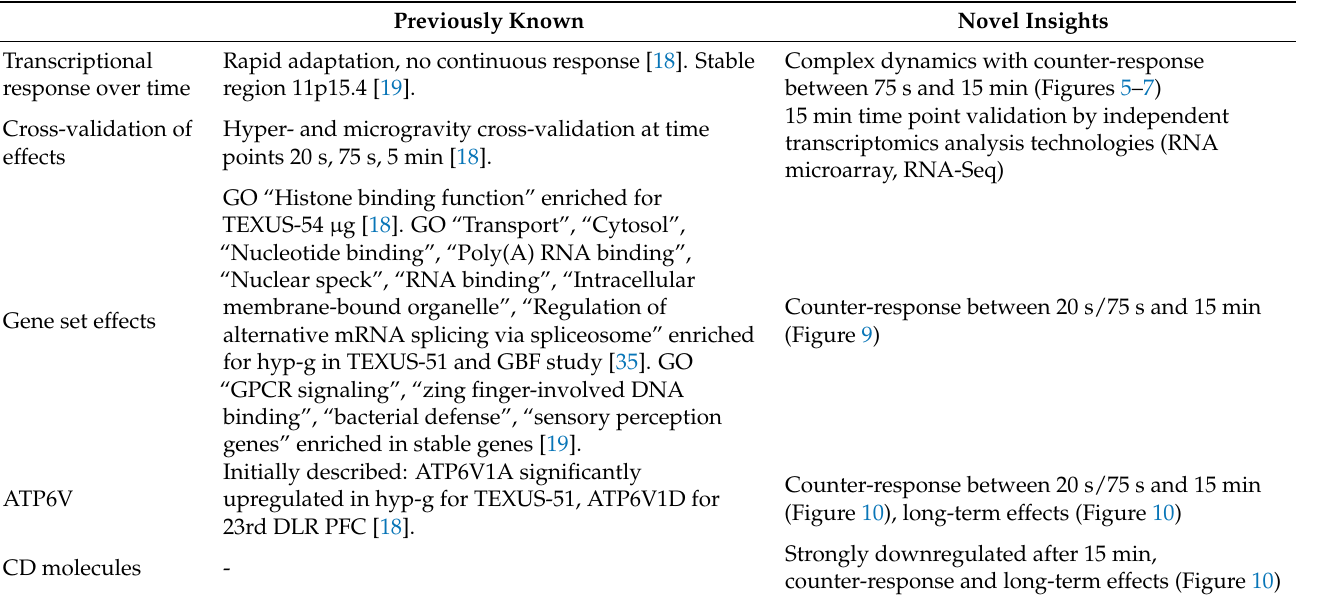
Table 3. Overview of novel insights from this work and how they add to the existing knowledge generated in previous studies.